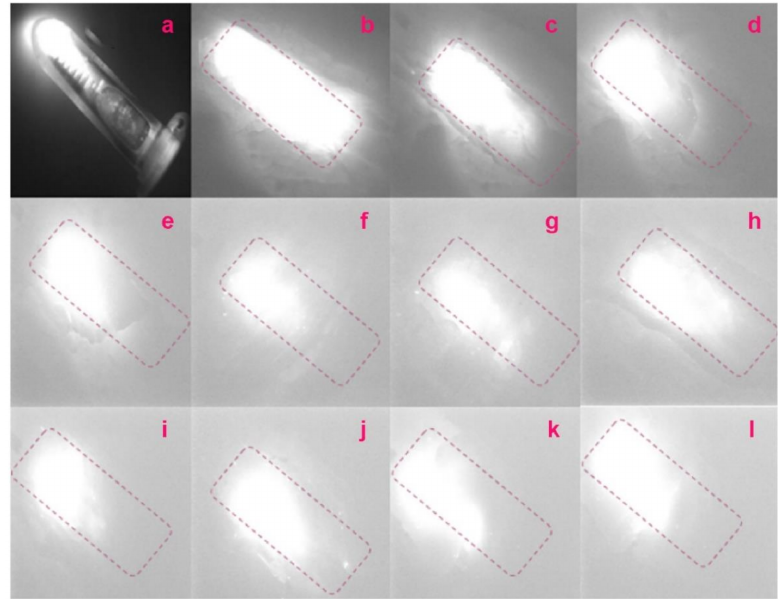
Figure 5. ( a ) Control image is a 2 mL centrifuge tube filled with Ho-oxide compound solution. The image of the tube under several layers of bacon meat: ( b ) one layer; ( c ) two layers; ( d ) three